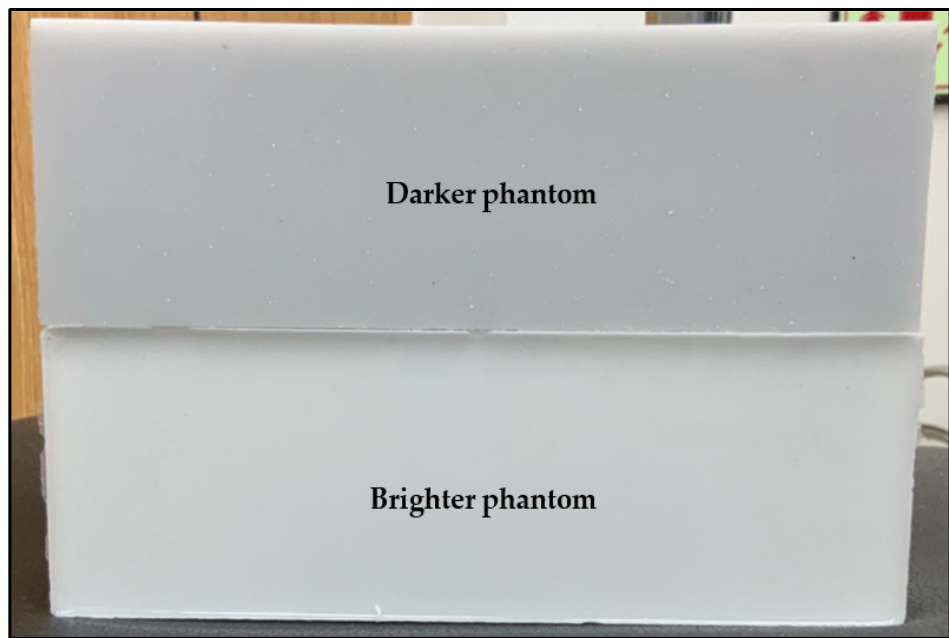
Figure 16. Darker and brighter silicone rubber phantoms.